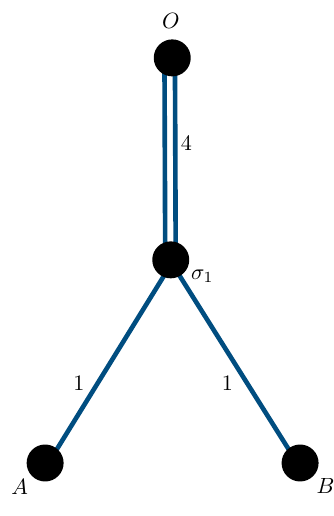
and e for a value of Aσ 1 Bσ 1 = 0 so that AB